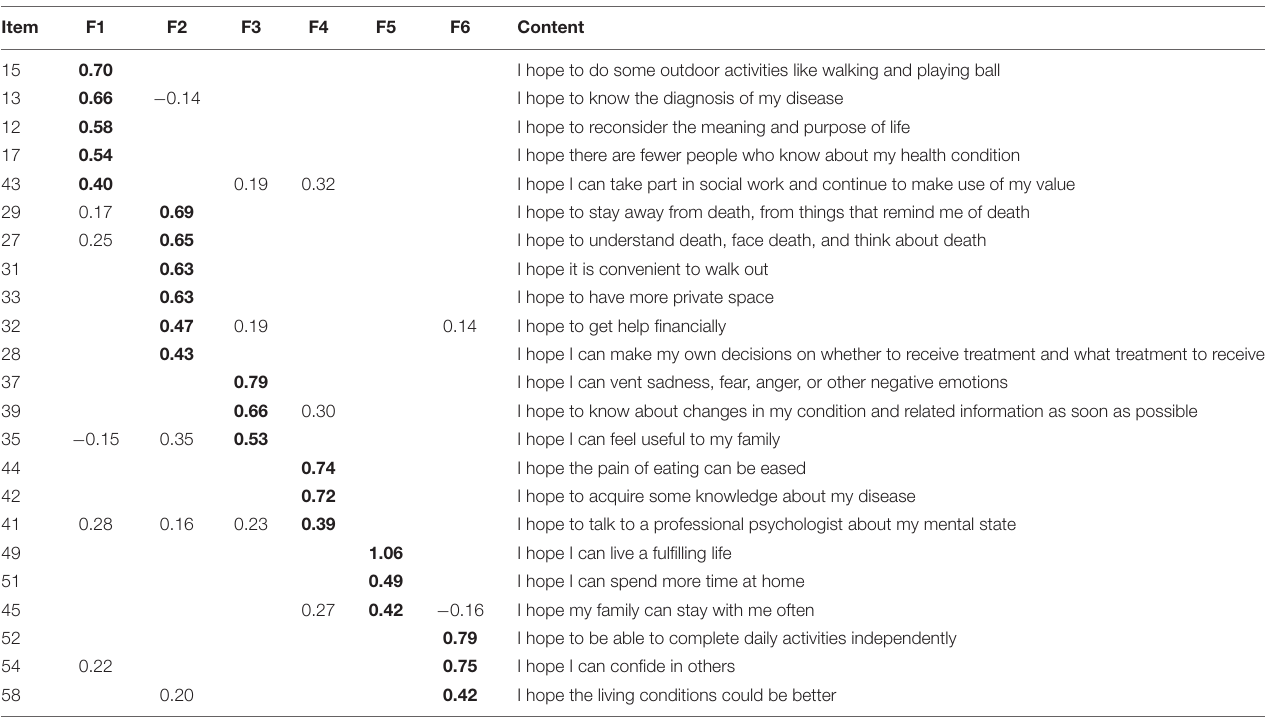
TABLE 2 | EFA: 23 items and corresponding factor loads.